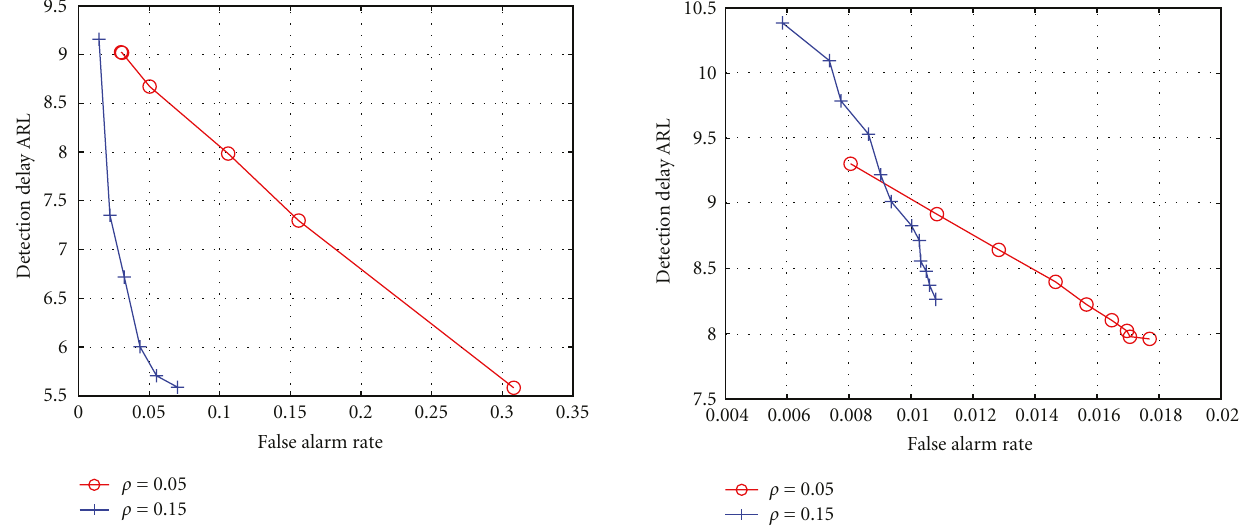
Figure 7: Tradeo ff between false alarm rate and detection delay ARL when discretized DP is used.